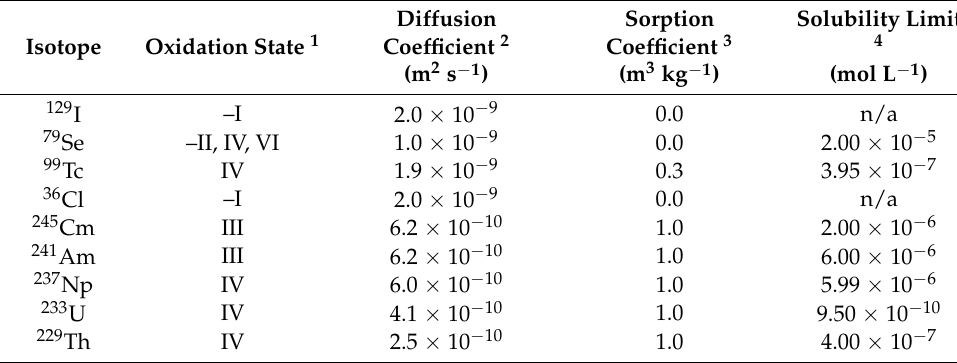
Table 3. Radionuclide-specific transport